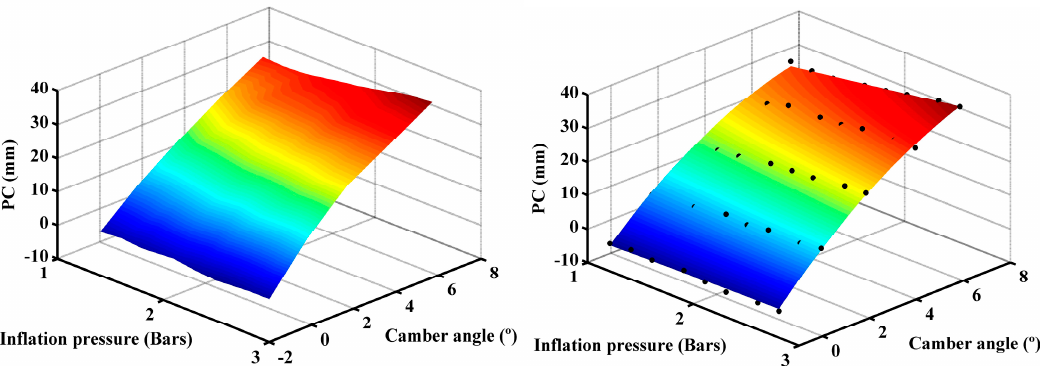
Figure 17. 3-D representation of the pressure center: measured data ( left ) and; fitted data ( right ).